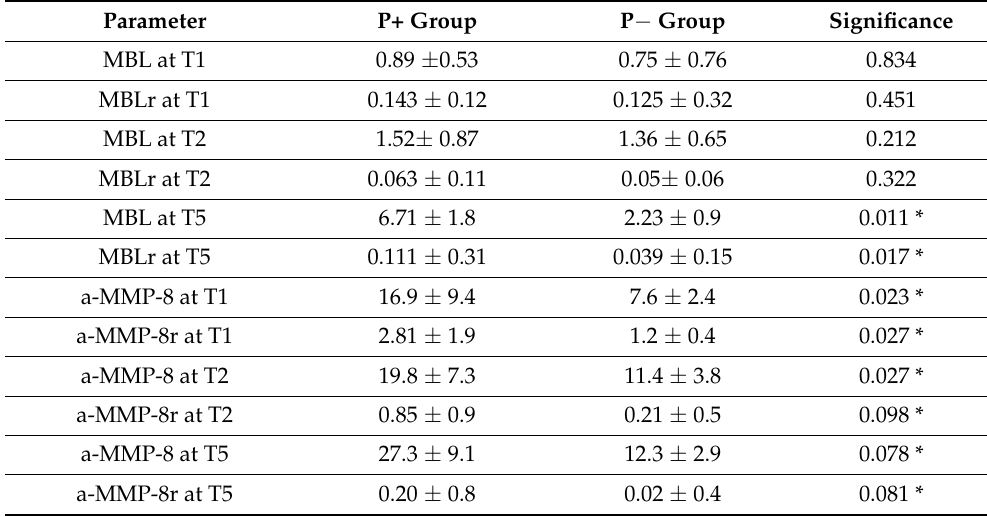
Table 4. Mean value of MBL, MBL rates (MBLr), a-MMP-8, and a-MMP-8 rates (a-MMP-8r)